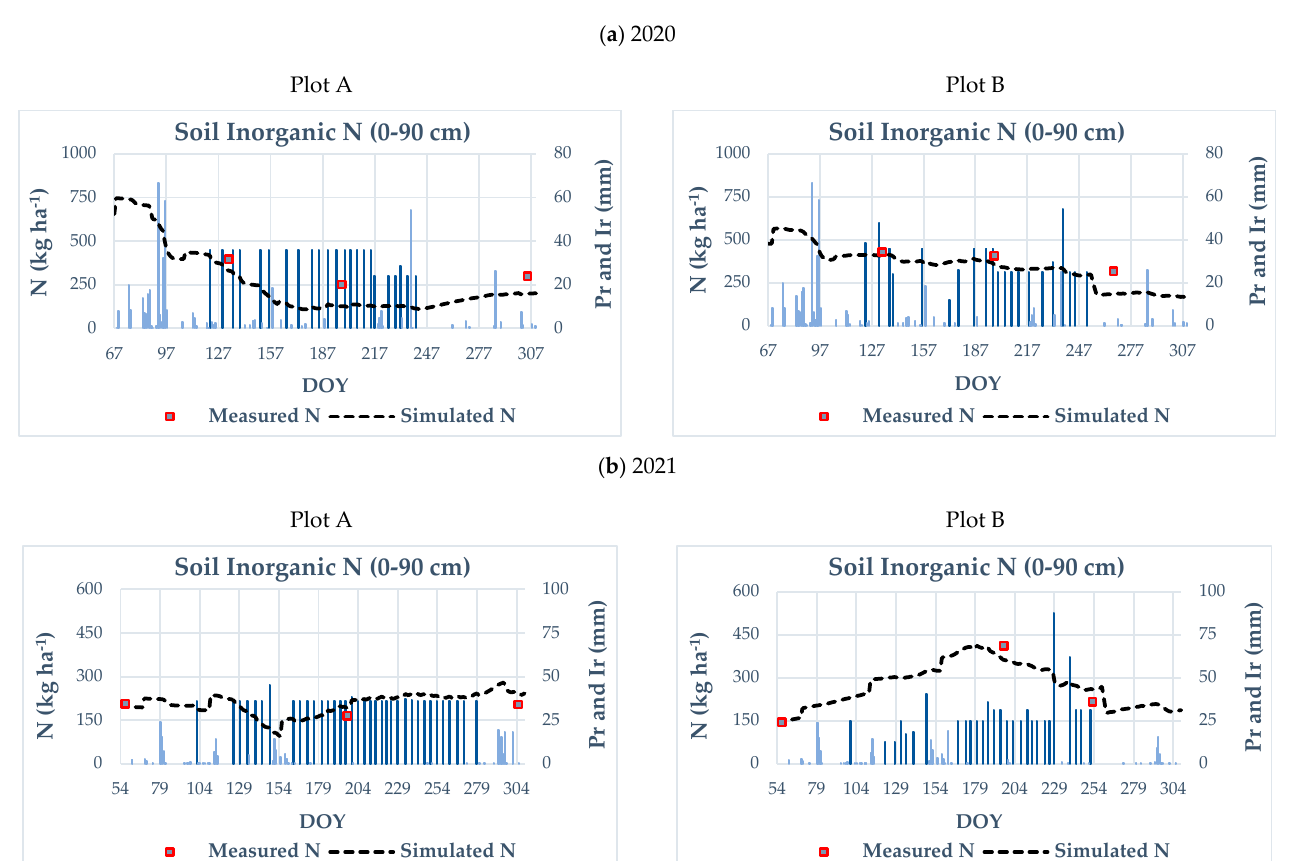
Figure 4. Soil inorganic N (sum of NH 4 -N and NO 3 -N) within the 0–90 cm depths, for plots A and B in ( a ) 2020 and ( b ) 2021; observed and simulated values by the CropSyst model. The blue bars show precipitation (Pr), whereas the dark blue bars show irrigation (Ir) water applied.